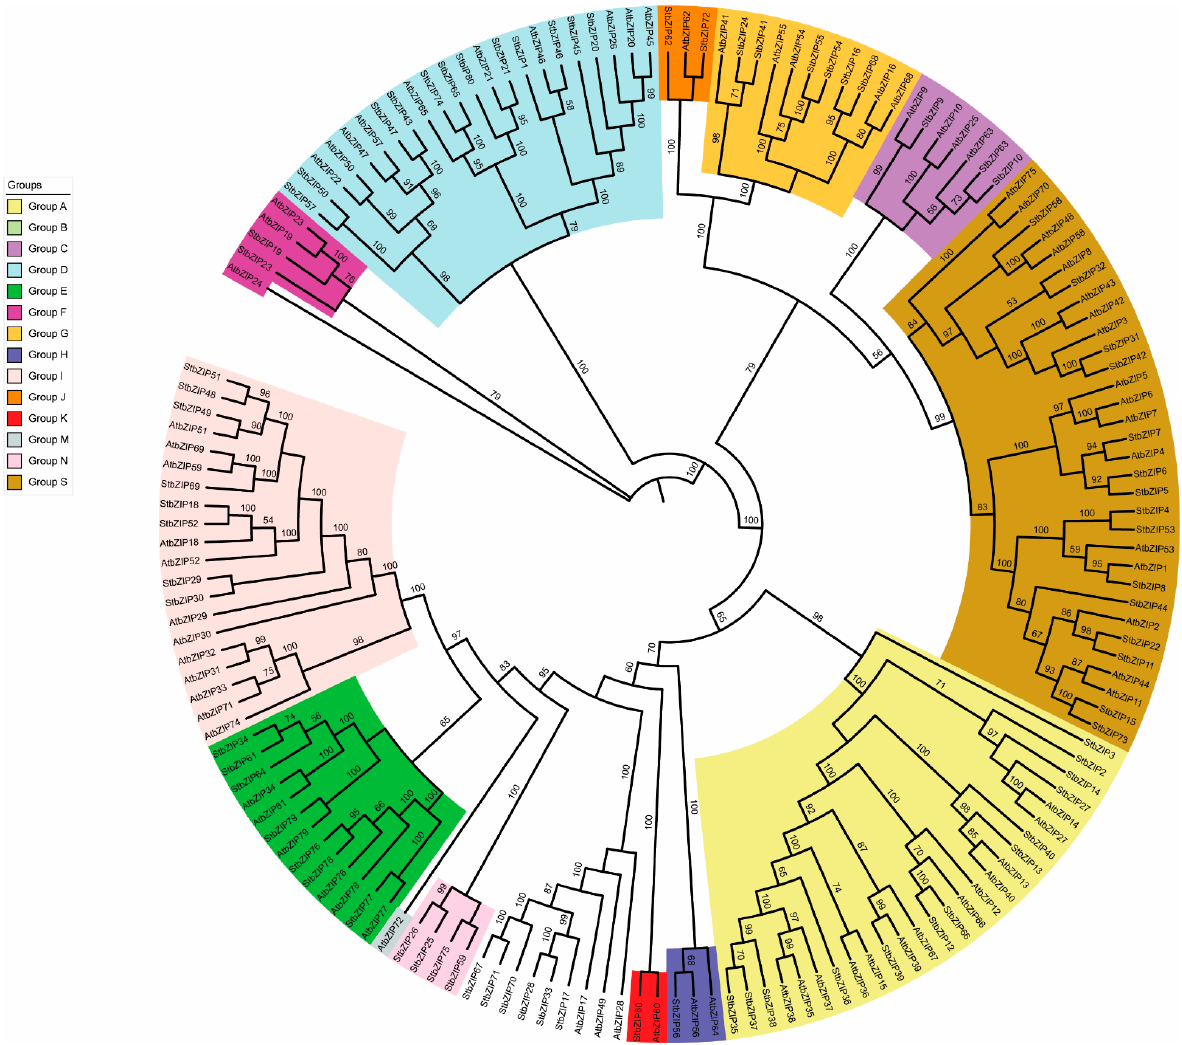
Figure 1. Phylogenetic tree constructed using PhyML method (v1.5) and Seaview (v4.7) contains the Arabidopsis and potato basic region-leucine zipper (bZIP) proteins. iTOL (v4) was used to visualize the output, and the diagrams were compiled, labeled, and color-coded using Adobe Photoshop CC (2017). Branch support was assessed with 1000 ultrafast bootstrap approximation and SH-aLRT branch test with 1000 replicates. The legend contains the functional groups assigned according to [8,10]. The bootstrap scores are provided at each node. Table 1. AtbZIP and StbZIP family members organized by